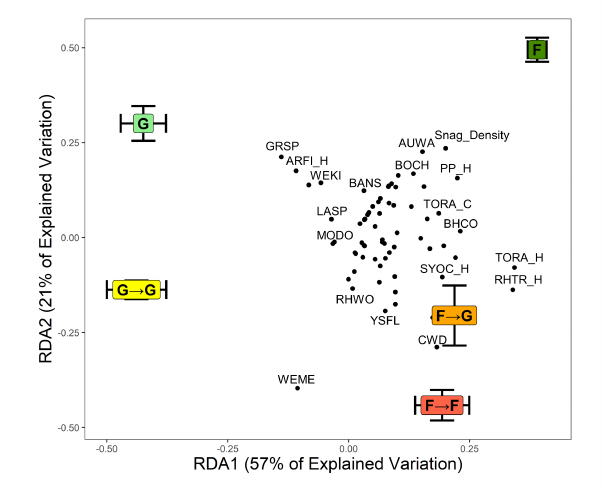
Fig. 4 . Redundancy analysis (RDA) of bird and understory woody plant community, understory woody plant structure, snag characteristics, and coarse woody debris constrained by transition class (unburned forest sites [F], forest sites that burned at low severity and are expected to resemble unburned forest [F->F], forest sites that burned at high severity and are expected to resemble unburned grassland sites [F->G], unburned grassland sites [G], and grassland sites that burned and are expected to resemble unburned grassland [G->G]). Points represent species score locations. Outer points have species labels. RDA1 largely differentiates among regimes while RDA2 represents variation driven by long-term legacy effects following